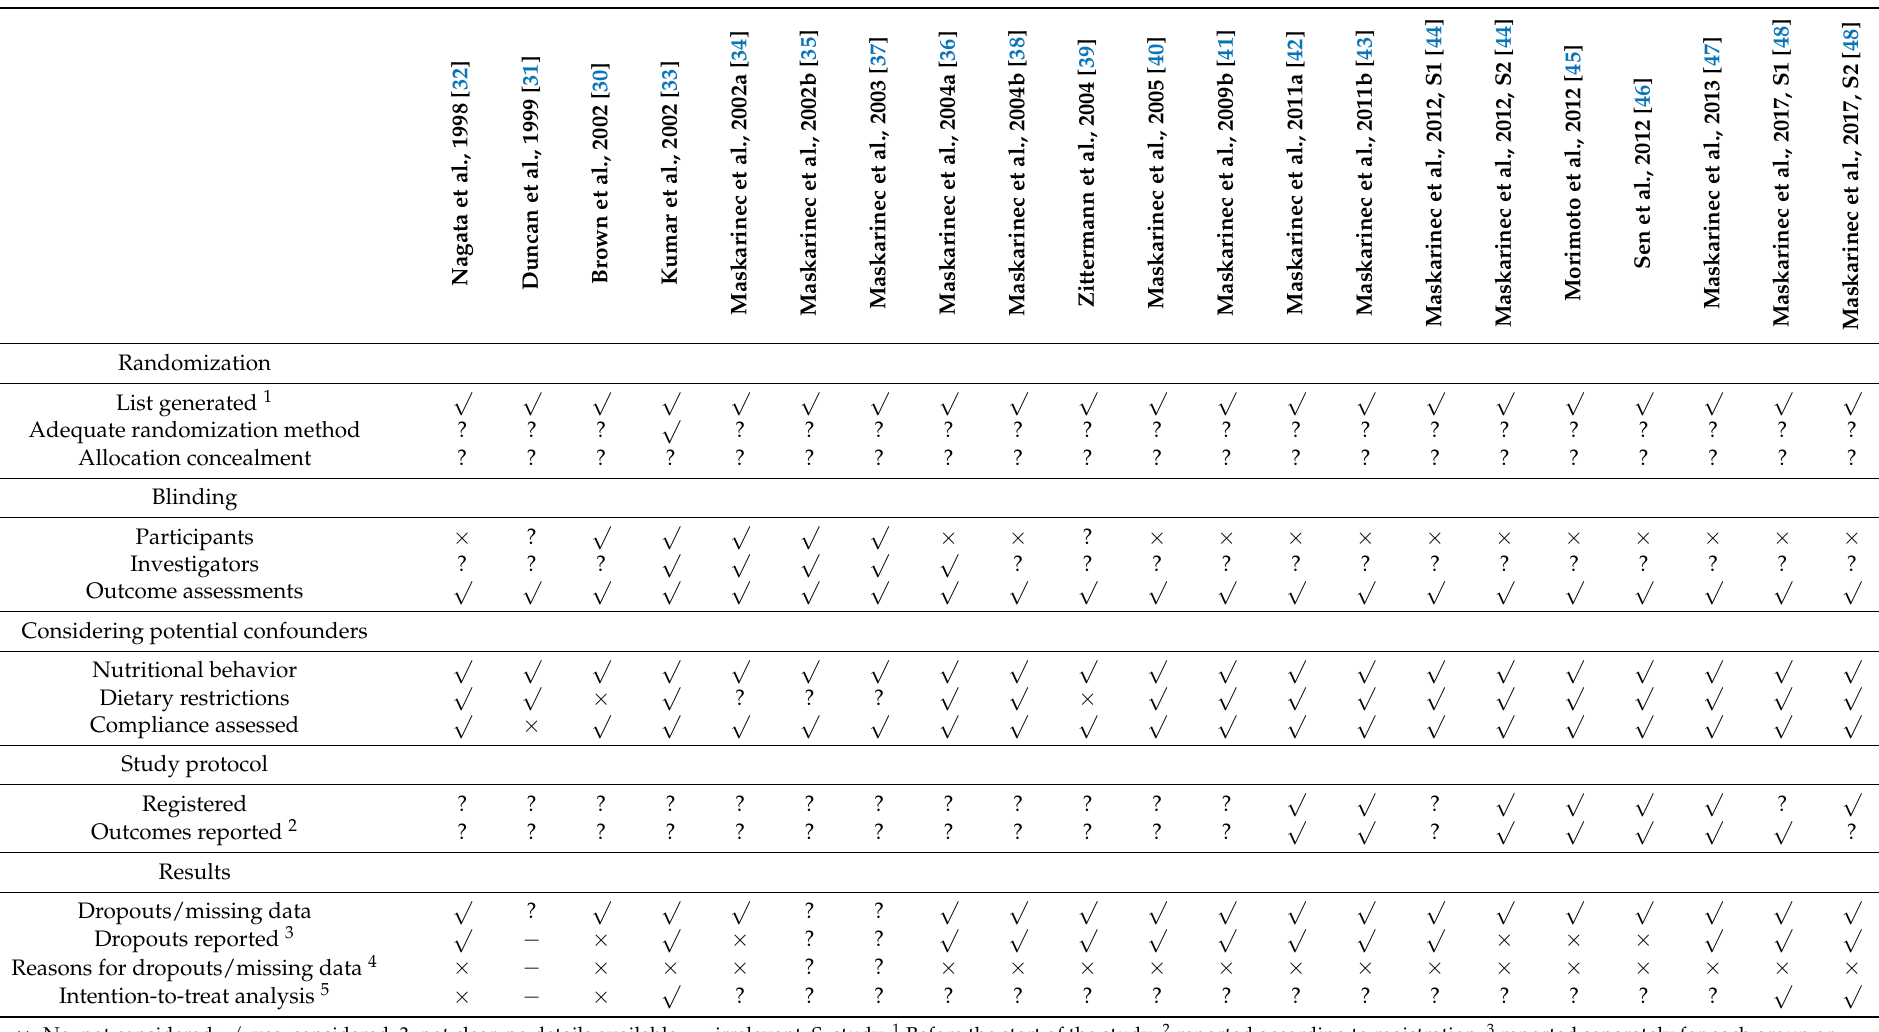
Table 4. Criteria to assess the risk of bias in studies with premenopausal